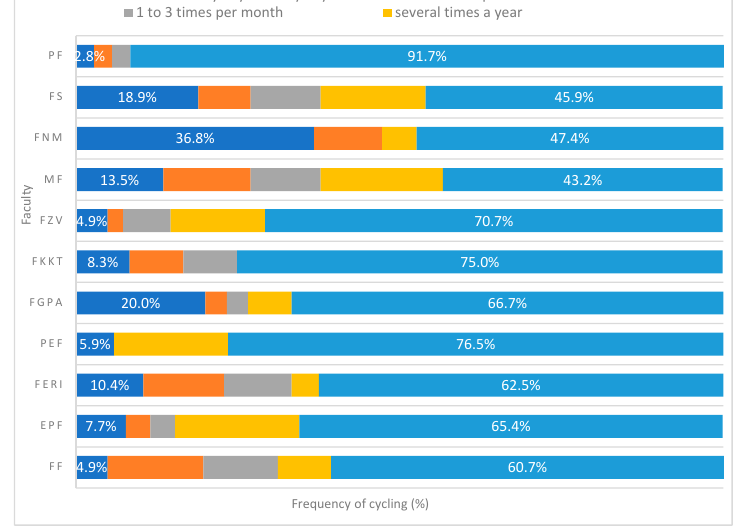
Figure 6. Frequency of cycling among students per faculties of the University of Maribor as percentages.